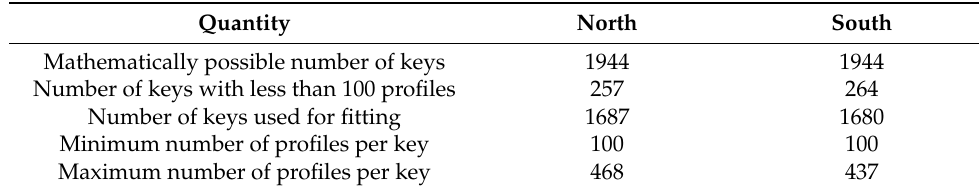
Table 5. Statistical information about the interval keys of the modeling dataset for the Northern and Southern Hemispheres.